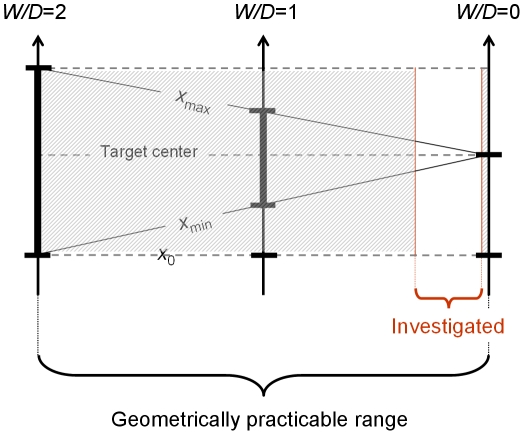
The geometrically available range of relative tolerance and the subset that is actually investigated in the Fitts paradigm of Eq. 8, using the discrete protocol.The x continuum of Figures 1–
3 is now oriented vertically, with the target interval shown as a thickened segment. W is made to decrease from left to right for a constant value of D, meaning that difficulty increases from left to right. The region of relative tolerance that is not used, and presumably not usable, is hatched.